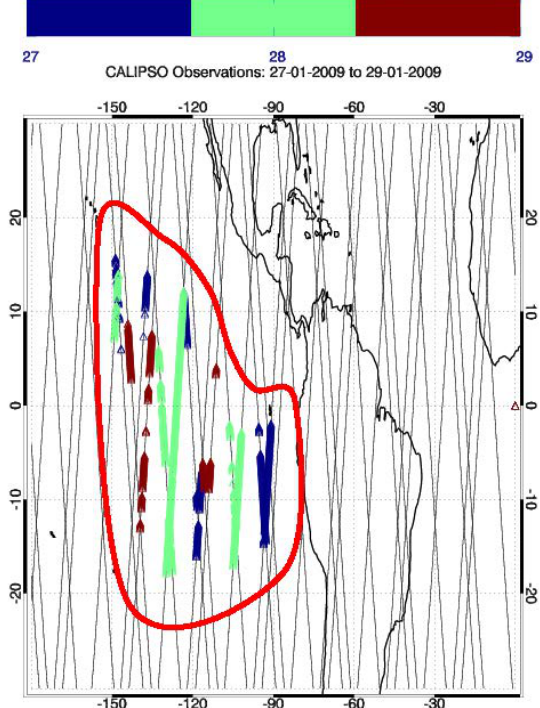
Fig. 3. The horizontal extent of the isolated TTL cirrus cloud over 27–29 January 2009. Colors indicate the presence of a cir- rus cloud over altitudes 13–18km, with no clouds from 5–13km. Blue, green,and red symbols represent observations on the 27, 28, and 29 January, respectively. The cloud shown in Figs. 1 and 2 can be seen in the middle of the region (long, continuous, green track), extending continuously from ≈ 15 ◦ S to ≈ 10 ◦